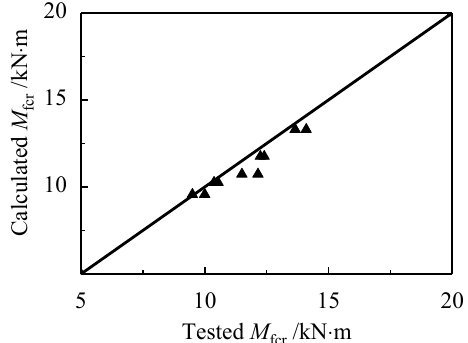
Figure 12. Test and calculated cracking moment of reinforced SFR-CRAC beams.